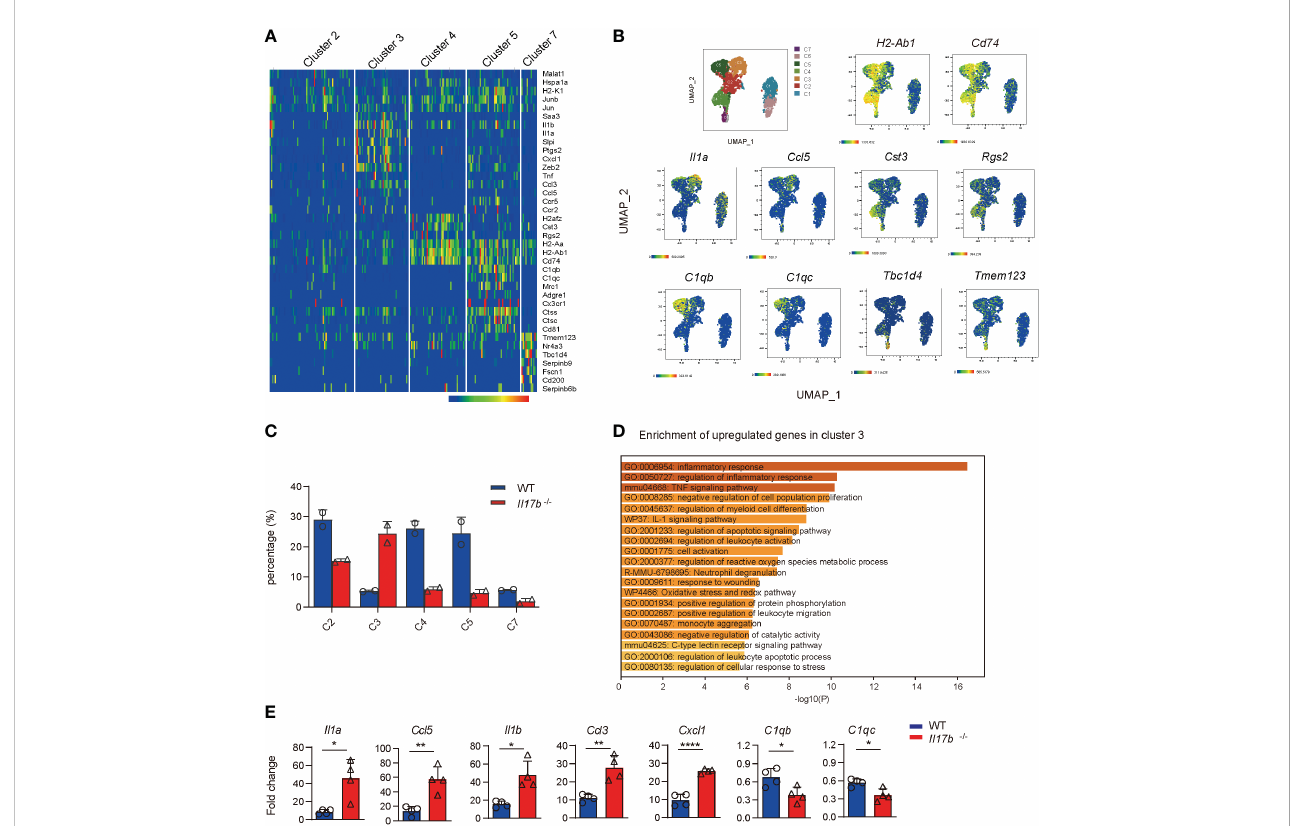
FIGURE 6 Increased in fl ammatory response in colonic macrophages in Il17b -/- colitic mice. (A) The heatmap shows the upregulated signature genes in colonic macrophages. (B) UMAP plots displaying marker genes expression for cell clusters. (C) Percentage of cell clusters of colonic macrophagse in WT and Il17b -/- colitic mice. (D) Gene enrichment of upregulated DEGs in cluster 3 of colonic macrophages. (E) The mRNA expression of some DEGs in colon lamina propria CD45 + cells of Il17b -/- and WT colitis mice were detected by real-time PCR. n = 7 for WT group and 6 for Il17b -/- mice. Data are expressed as mean ± SD. * P < 0.05, ** P < 0.01, **** P < 0.0001, determined by unpaired t